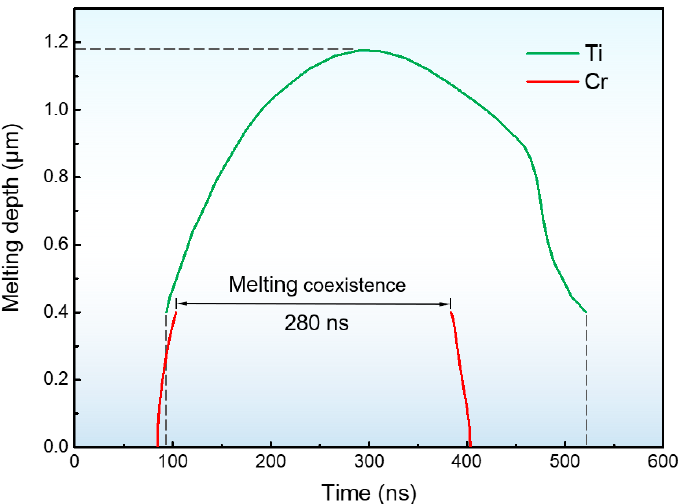
Figure 4. Evolutions of melting depth in the Ti substrate with 400 nm Cr fi lm under IPIB irradiation.